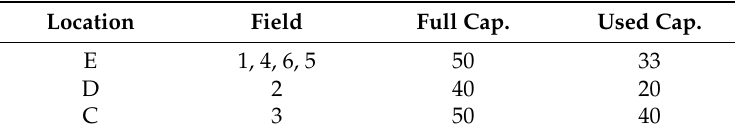
Table 4. The result of steps 1 and 2 in the current practice procedure. Location Field Full Cap. Used